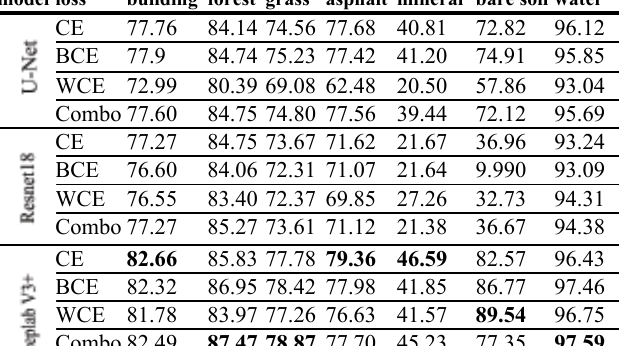
Table 3. IOU in percentage for each class and architecture